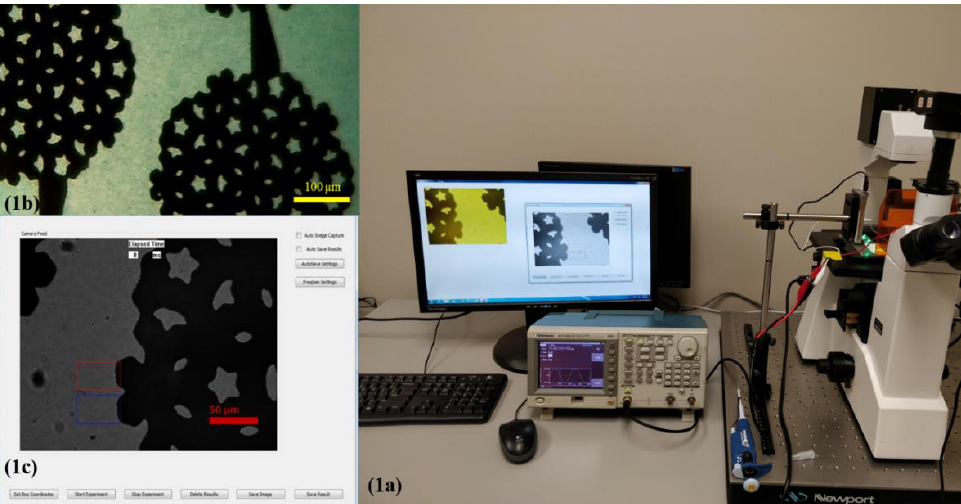
Figure 1. Single nucleotide polymorphism (SNP) sensor prototype: ( a ) experimental setup, ( b ) interdigitated electrode used in the experiments. The electrode is visible as the darker region in the picture. The yellow scale bar indicates 100 µm. Multi-colored hollow rectangles depict the regions of interest for measurements and analysis. ( c ) Interface of Microsoft Windows application for dielectrophoresis (DEP) spectroscopy. The red scale bar indicates 50 µm.